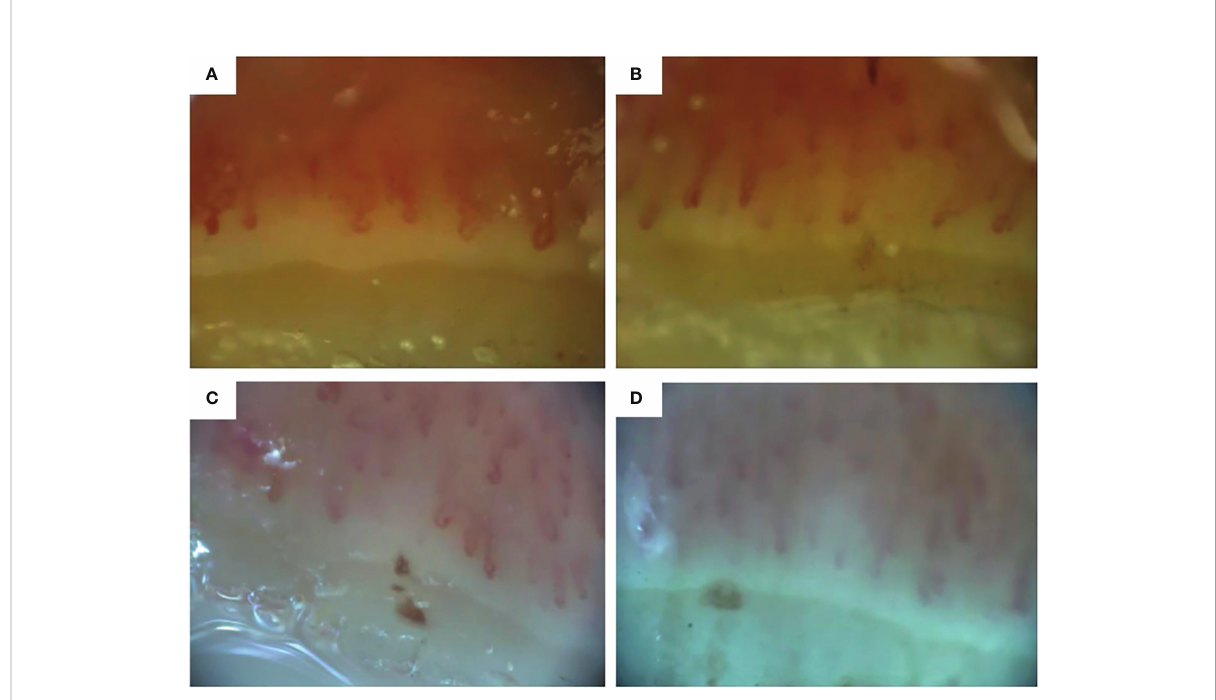
FIGURE 2 Nailfold capillaroscopic images of digit 4 right (A) before fi rst hematopoietic stem cell transplantation (HCT), (B) 6 months after the fi rst HCT, (C) before the second HCT and (D) 6 months after the second HCT. Images A and B obtained with Videocap 3.0, images C and D with